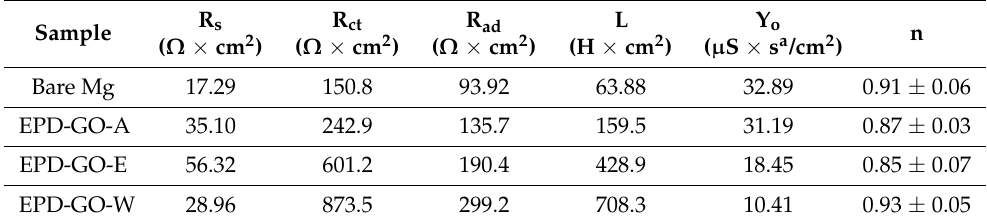
Table 2. Impedance values obtained after EEC fitting.